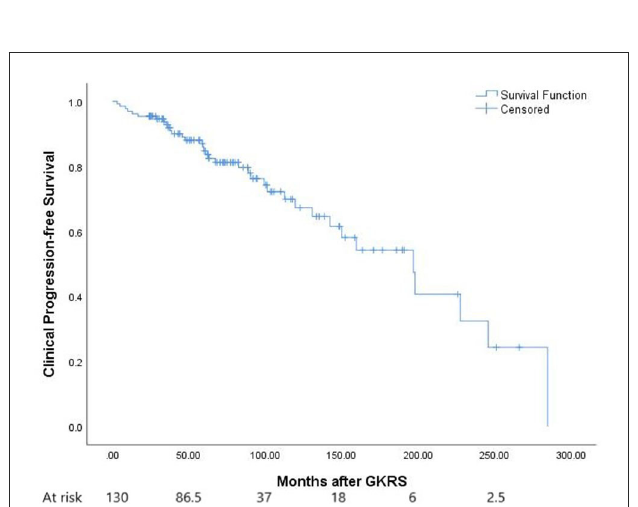
FIGURE5 The Kaplan–Meier curve of clinical PFS in the entire series. Clinical PFS was 96, 91, 84, and 67% at 1, 3, 5, and 10 years.